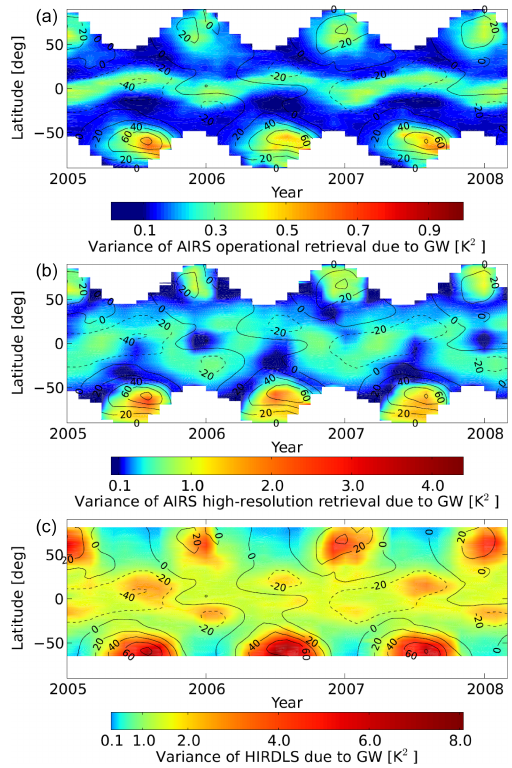
Figure 10. Time series of monthly temperature variances due to gravity waves between 2005 and 2008 at 30km altitude. (a) AIRS operational retrieval. (b) AIRS high-resolution retrieval. (c) HIRDLS. Contour lines indicate zonal mean wind from ERA- Interim. Please note the different color bar ranges.